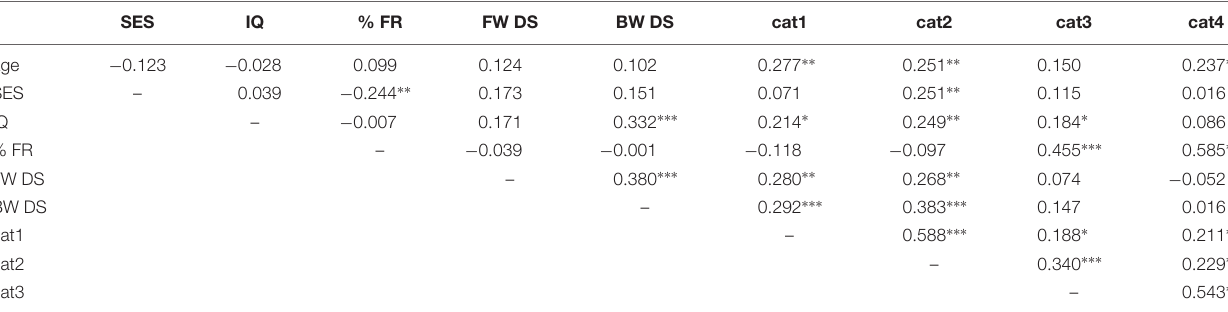
TABLE | Bivariate correlations among all variables at Time